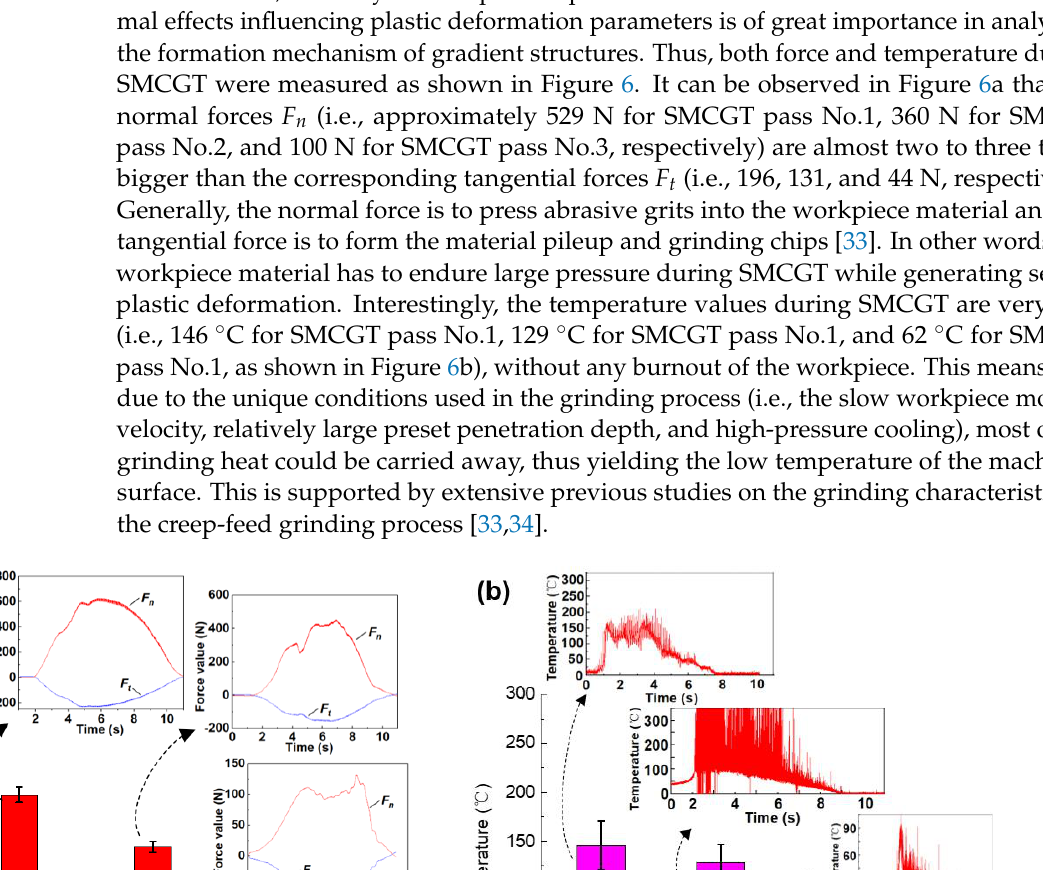
Zener – Hollomon parameter Z is introduced as follows [35]: